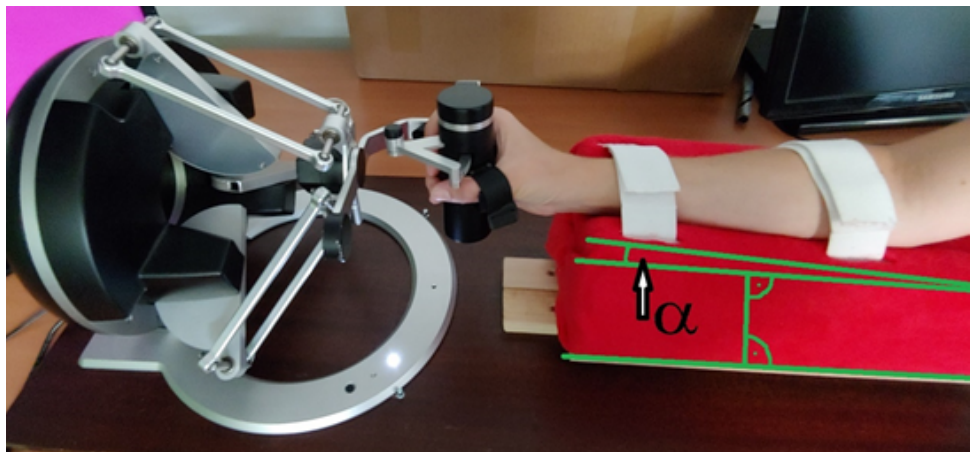
Figure 6. Measurement station with forearm